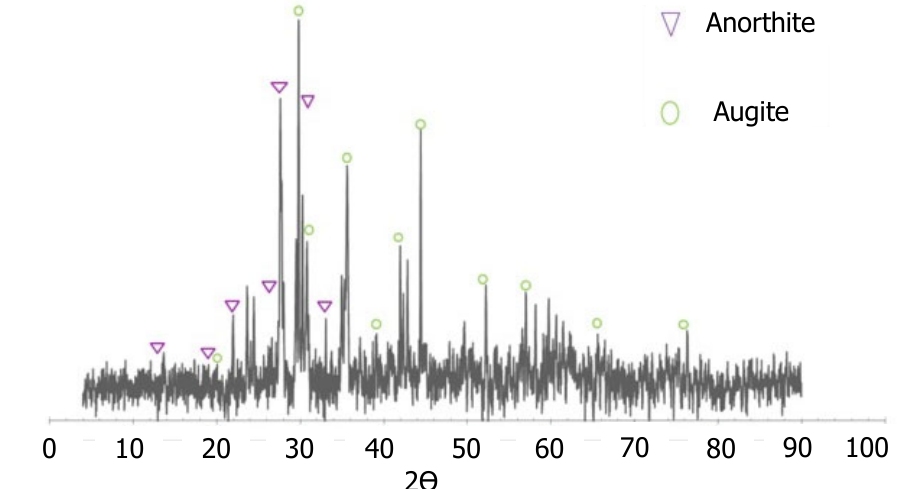
Figure 4. XRD diffraction pattern of volcanic material (black sand). Hg porosimetry and N 2 physisorption were used to analyse the photocatalytic mate ‐ rial’s pore volume distribution and specific surface, respectively. Figure 5 shows the pore size distribution of black sand by Hg porosimetry and N 2 physisorption. The black sand shows a predominance of macropores in the structure of the material. Adsorption iso ‐ therms of N 2 result in a specific surface of 0.188 m 2 /g and mean micropore diameter of 3.9 nm. Meso ‐ and macroporous structure analysis is shown in Table 1, including the porosity and density of the studied natural material.